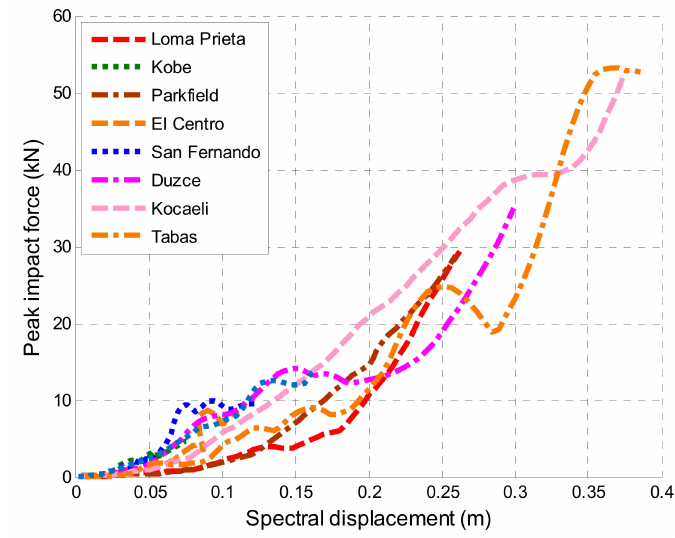
Figure 6. Peak impact force with relation to spectral displacement under di ff erent earthquakes. Table 2. Largest peak impact forces—results for di ff erent structural